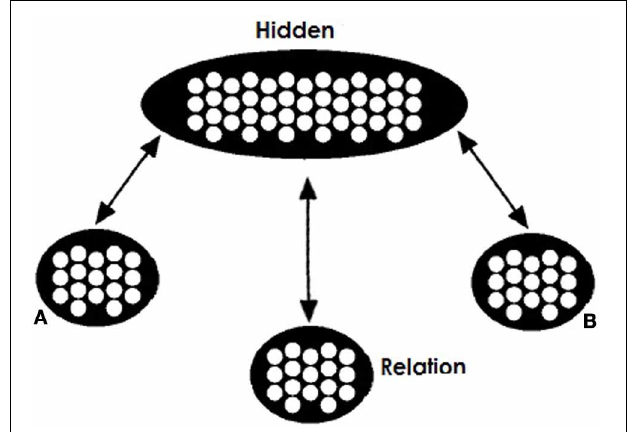
FIGURE 1 | Model’s training architecture. The network consists of two visible pools (A and B) for the two concepts in a relation, a visible pool (Relation or R) for the relation between them, and a hidden pool. Connectivity between pools is bidirectional.